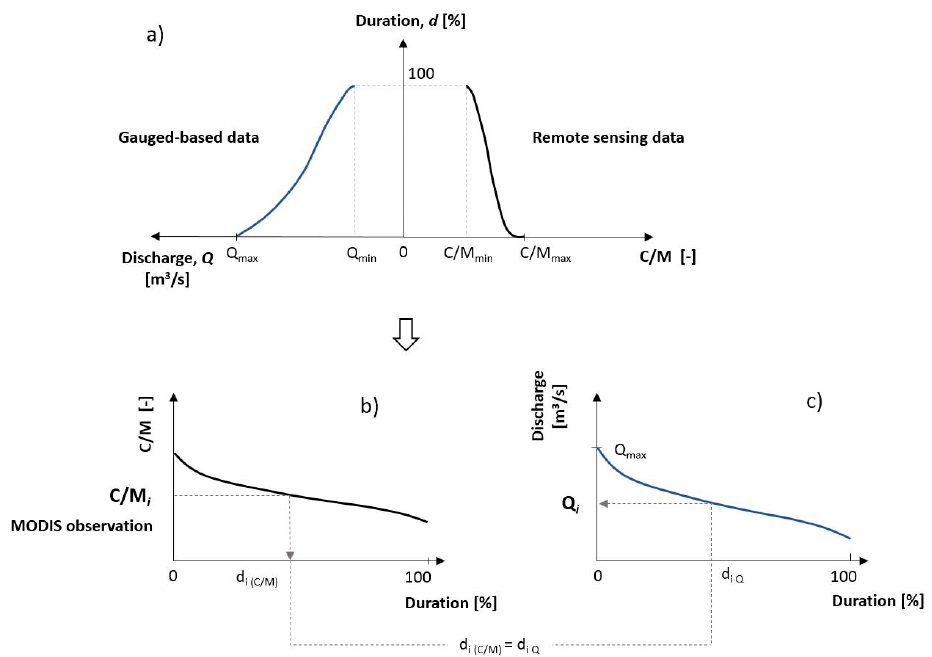
Figure 3. Conceptual scheme of the procedure between ground-based and remote sensing data. ( a ) schematic representation of the relationship between Discharge Q and remote sensing data, C/M through their duration; duration curve in terms of remote sensing, C/M ( b ) and discharge Q ( c ).